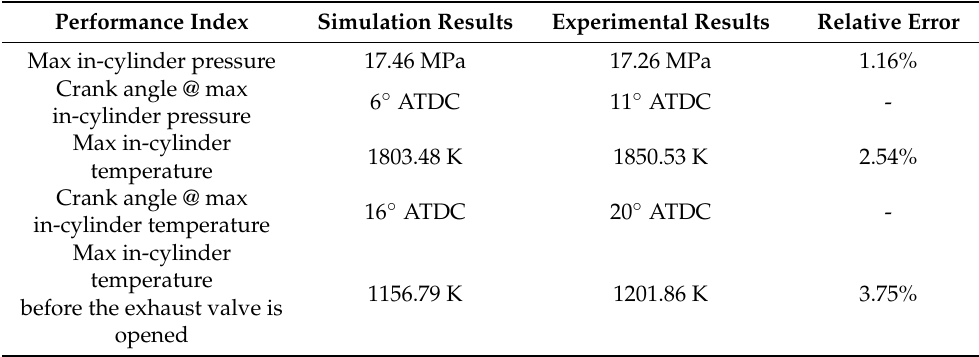
Figure 2. Single cylinder diesel engine test system. Table 1. Comparison of simulation results and experimental